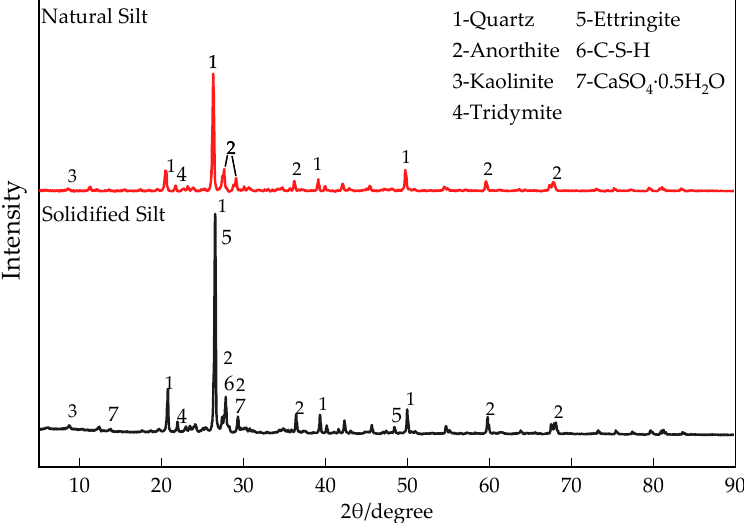
Figure 13. XRD pattern of natural silt and stabilized silt with 28d